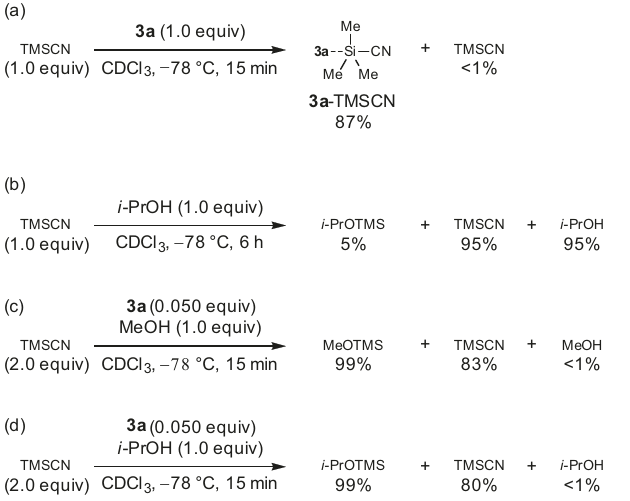
Fig. 3 Results of NMR studies. a TMSCN: 3a = 1:1. b TMSCN: i -PrOH = 1:1. c TMSCN:MeOH: 3a = 2:1:0.05; the generation of TMSOTMS was also observed in 12% yield. d TMSCN: i -PrOH: 3a = 2:1:0.05; the generation of